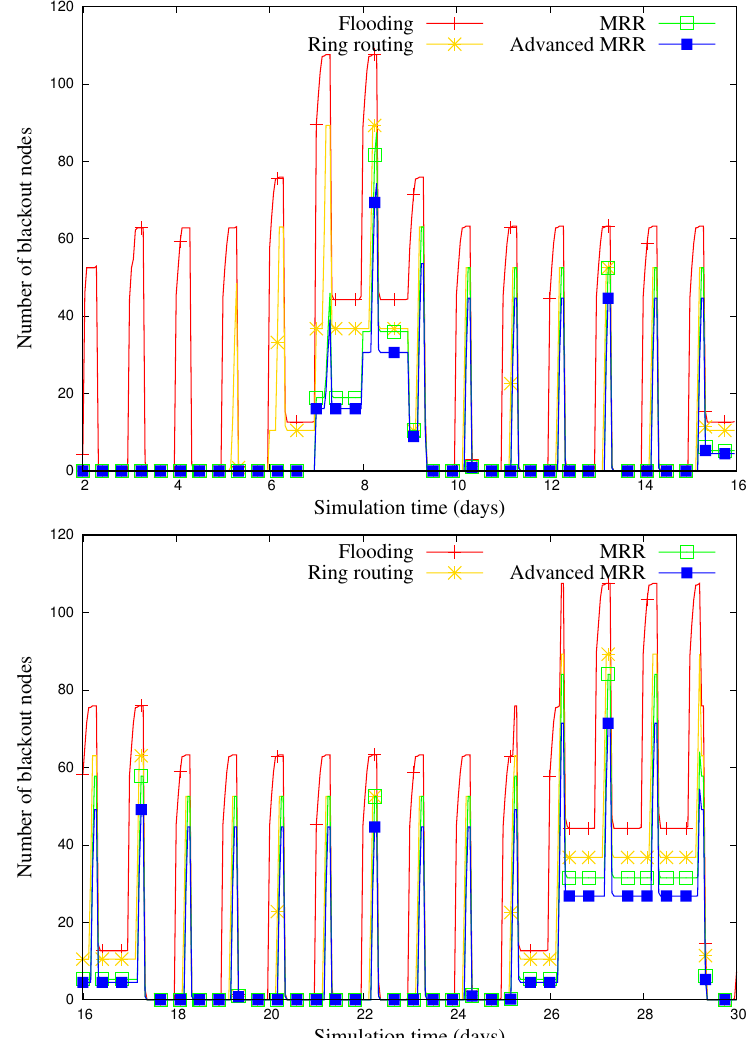
Figure 15. Tracing the number of blackout nodes on a sample run out of 50 runs when the number of nodes is 600 (6th ∼ 9th day: rainy, 16th ∼ 17th day: cloudy, 25th ∼ 29th day: rainy, and others: